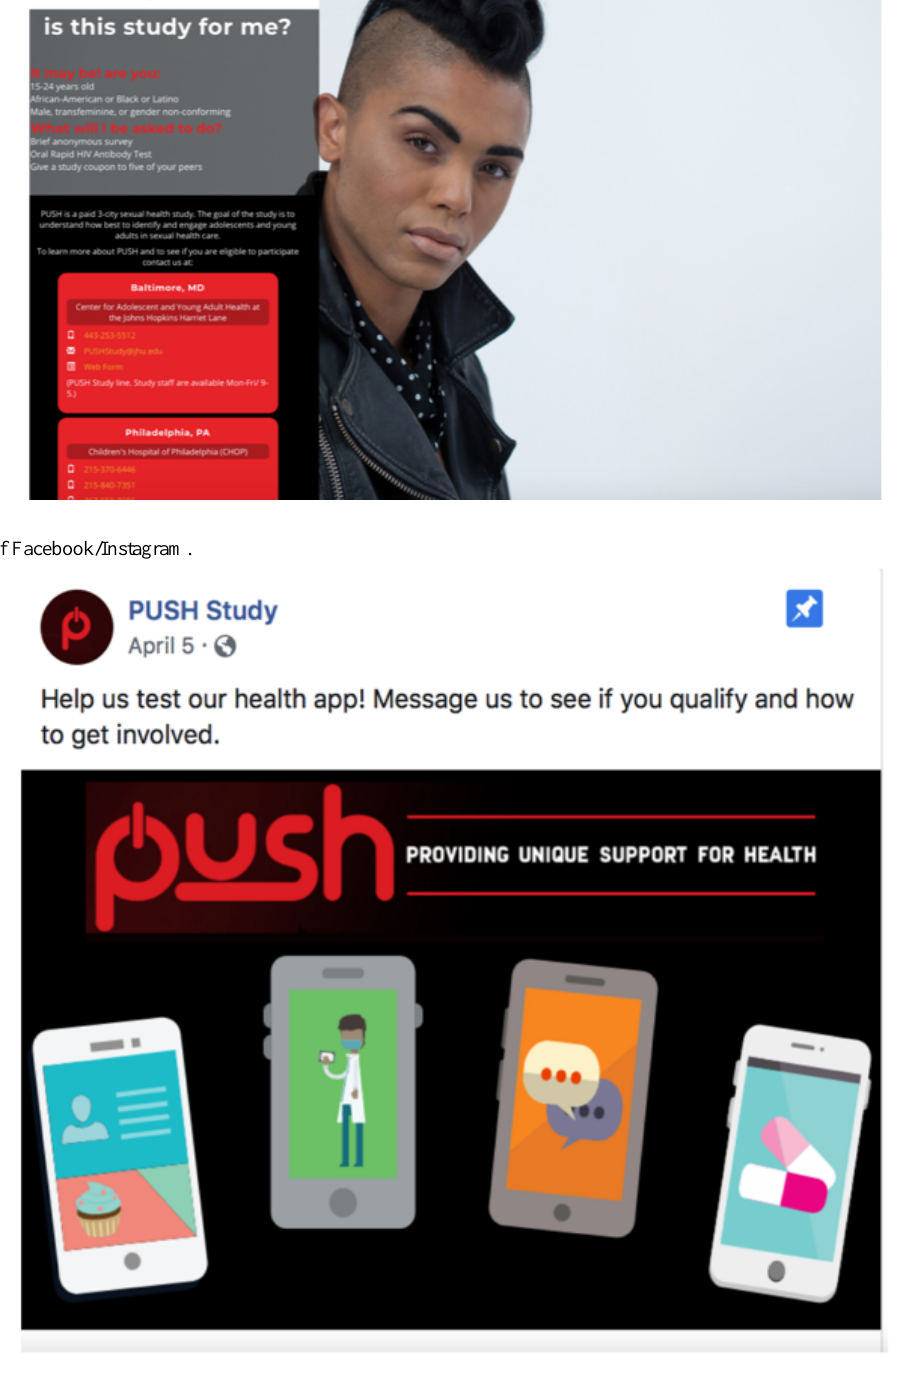
Figure 3. Web-based Flyer.